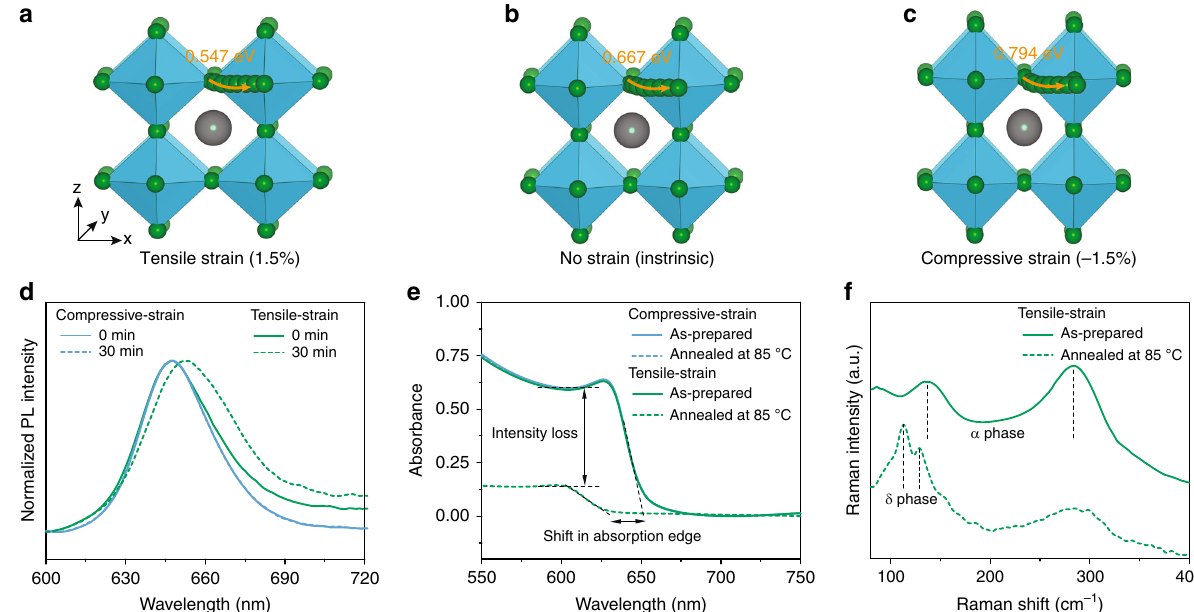
Fig. 3 Stability of perovskite fi lms under different strains. Calculated activation energies for halide ion migration in perovskites under biaxial ( a ) 1.5% tensile strain, ( b ) no strain and ( c ) − 1.5% compressive strain. d Normalized PL spectra of compressive-strain and tensile-strain perovskite fi lms after illuminating for 0 and 30 min. e Absorption spectra of compressive-strain and tensile-strain perovskite fi lms before and after annealing at 85 °C for 60 h. f Raman spectra of tensile-strain perovskite fi lm before and after annealing at 85 °C for 60